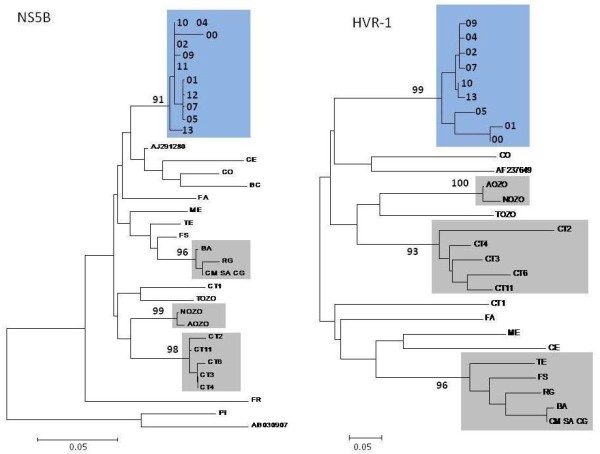
Phylogenetic tree analysis of NS5B and HVR1 region of HCV. The analysis of NS5B was performed for 10 incident cases and the index case (all genotype 2c). The analysis of HVR1 was possible for 8 incident cases only. Molecular analysis was not performed for 3 incident cases due to low viral load (< 615 UI/ml). Blue boxes include the viral variants from subjects in the current outbreak; each code refers to only one subject. Code 00 indicates the index case. Code 02, 04, 07, 09, 10, and 13 are confirmed cases dialysed on 20 April afternoon shift. Code 01 and 05 are confirmed cased who did not undergo dialysis on 20 April. Code 11 and 12 are possible cases (analysis of HVR-1 not available) dialysed on 20 April afternoon shift. Gray boxes include viral variant from other unrelated outbreaks.